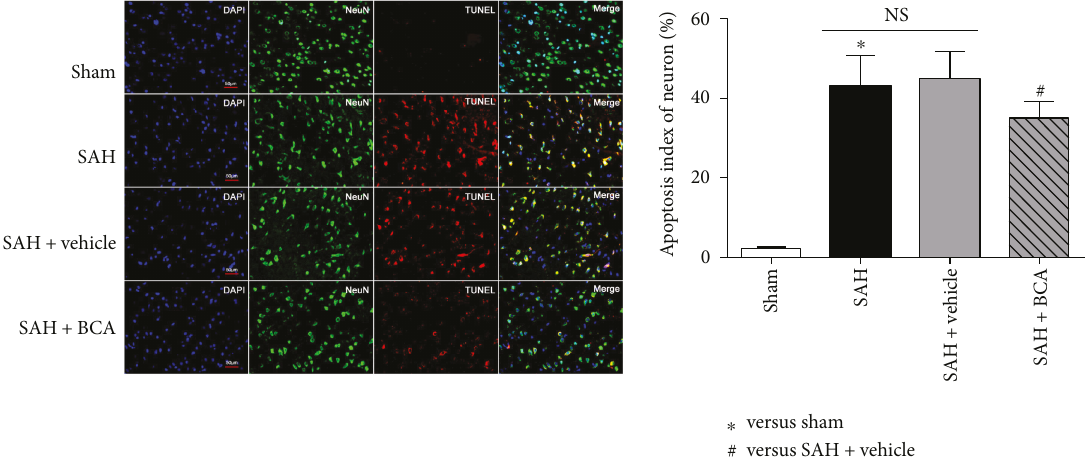
Figure 9: BCA attenuates the level of TUNEL-positive neurons at 24 hours post SAH. (TUNEL =red, NeuN =green, DAPI=blue, scale bars 50 μ m n = 6 , each group; ∗ P < 0 05 versus sham; # P < 0 05 versus SAH+ vehicle; NS P > 0 05